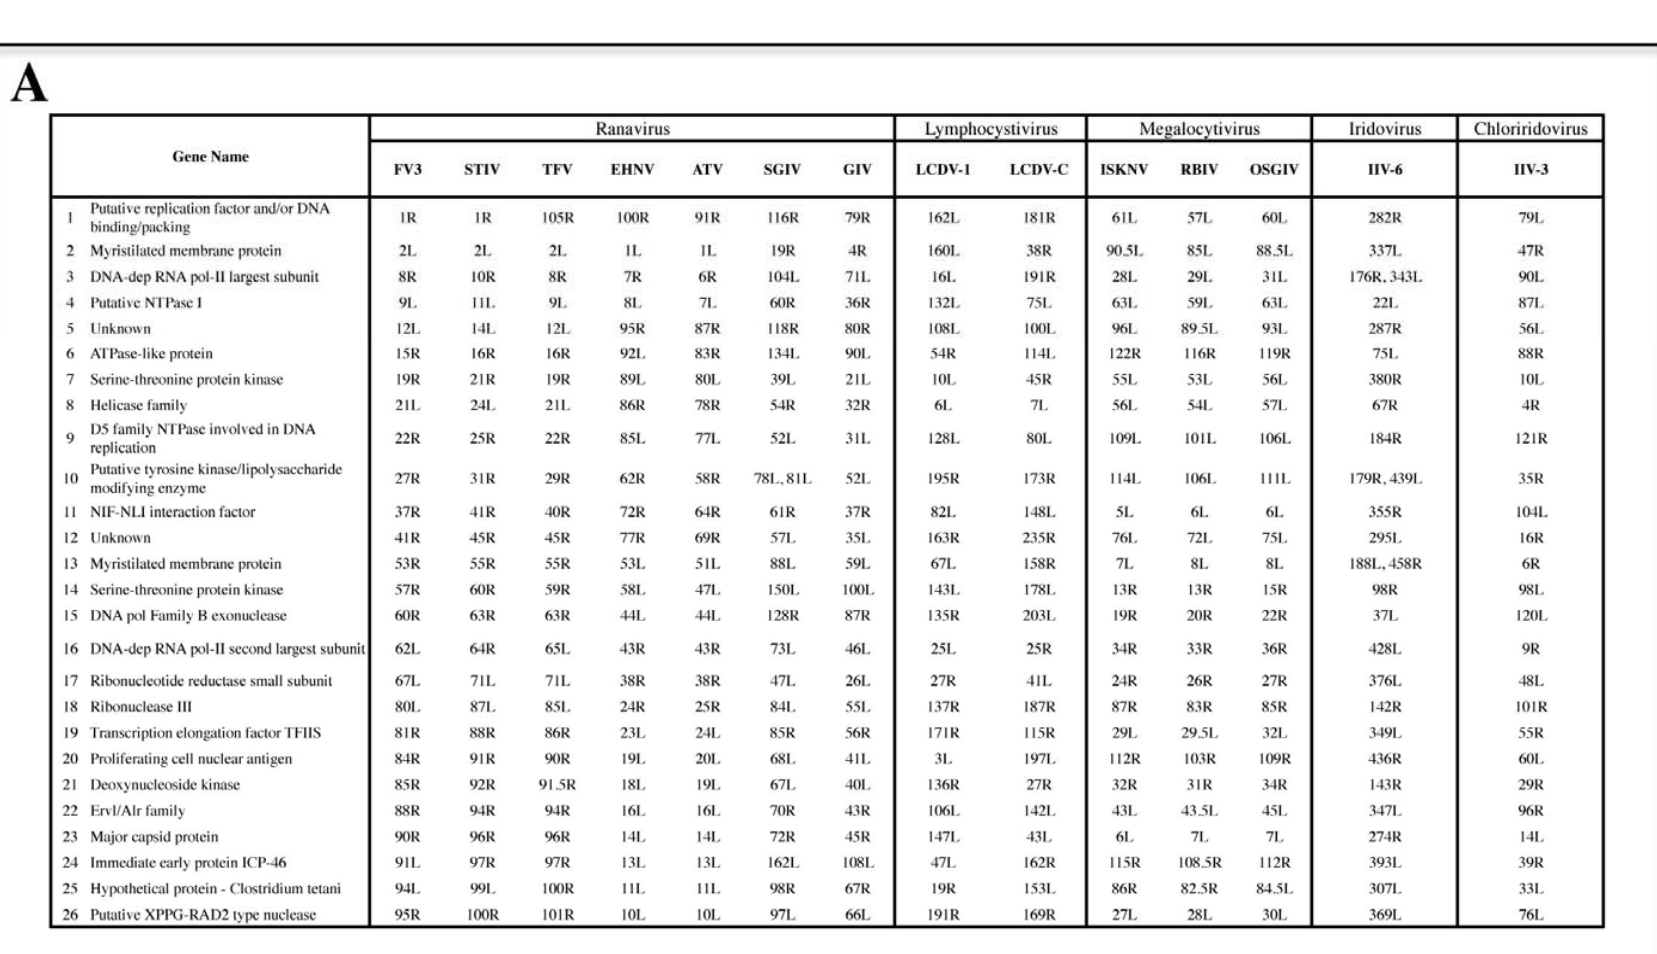
Figure 1 . The phylogenic relationship of 14 iridoviruses as identified by comparison of 26 conserved iridovirus genes. (A) ORF’s of 26 conserved iridovirus genes were recorded from 14 iridoviruses. (B) The nucleotide sequence of the conserved genes were aligned and fused to create a neighbor-joining consensus tree. The numerical values adjacent to the branching nodes indicate bootstrap values (black) and the number of genes in common between genomes (red). This tree was constructed in MEGA4.1 using the p-distance model at 500